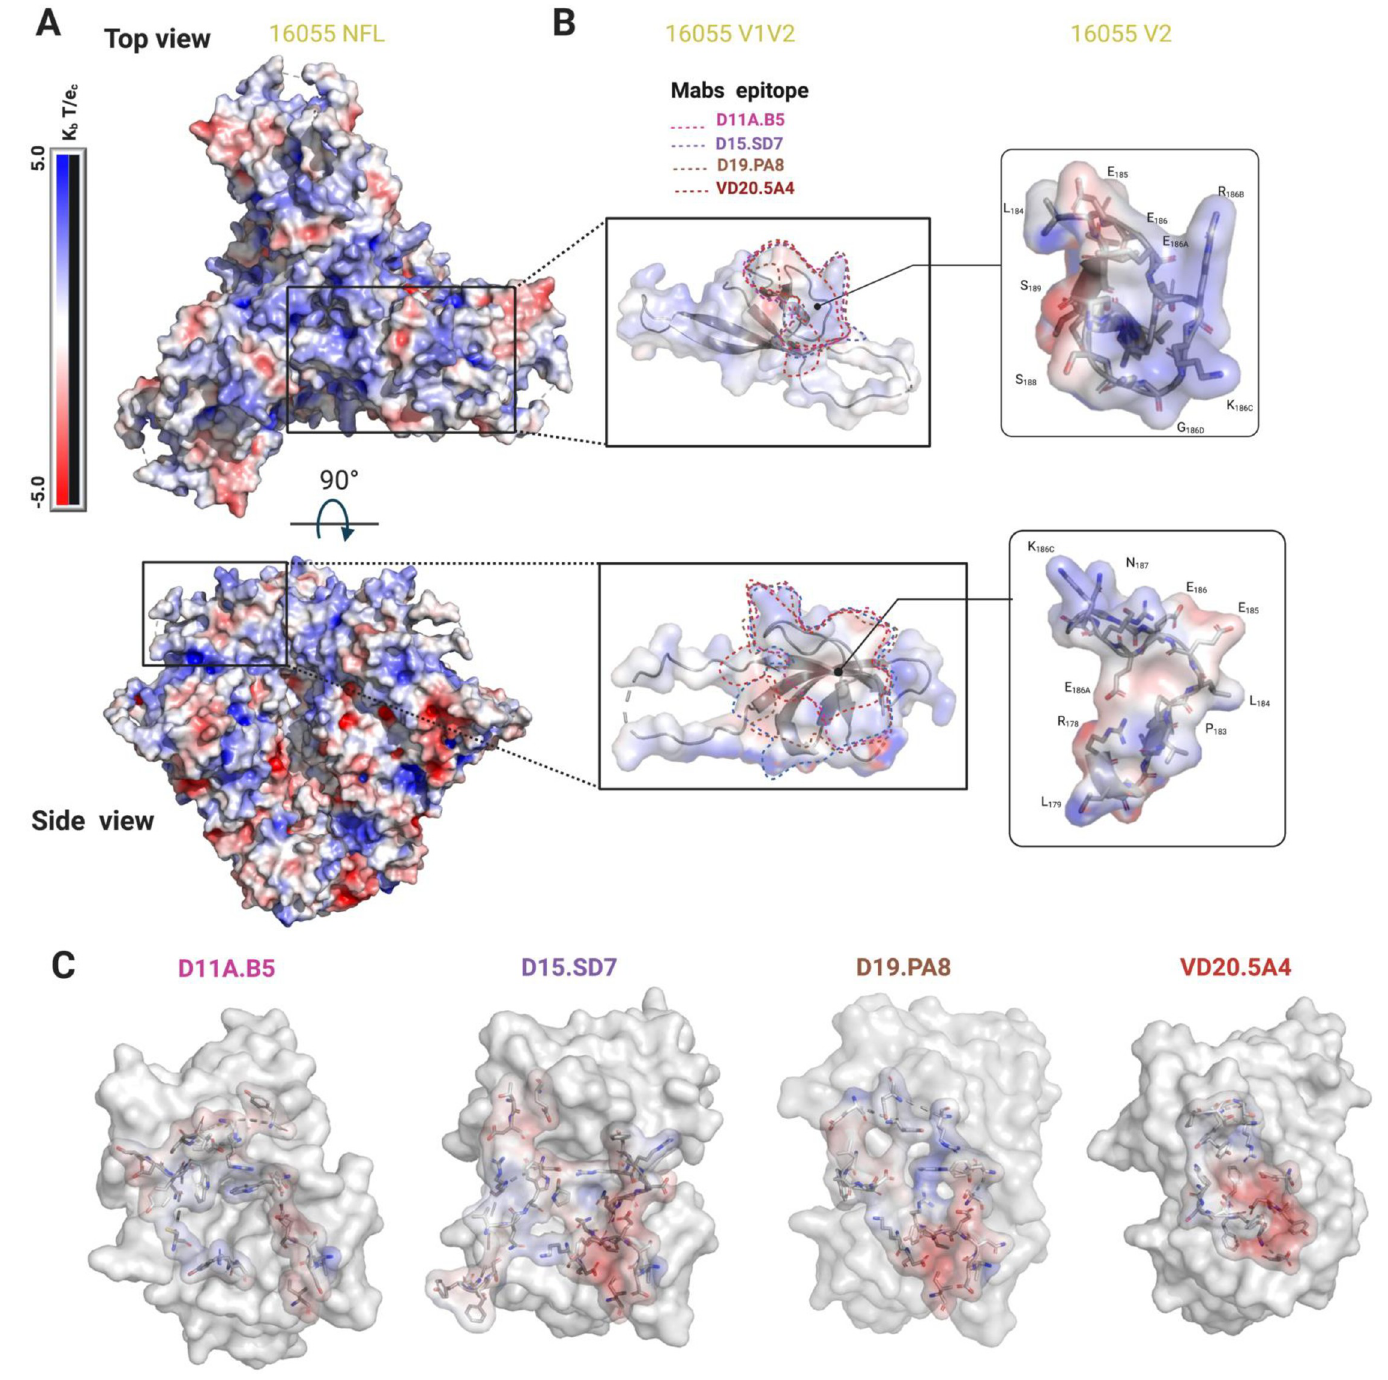
Fig 5. Electrostatics surface representation of 16055 NFL and different mAbs. Electrostatics surface representation of (A) 16055 NFL and ( B) V1V2 and V2 region zooms (top and side views). Epitopes are highlighted by dotted lines and some residues in V2 are shown in stick and labeled. ( C) Electrostatics surface representation of the mAbs paratope. Residues forming the paratope are shown in